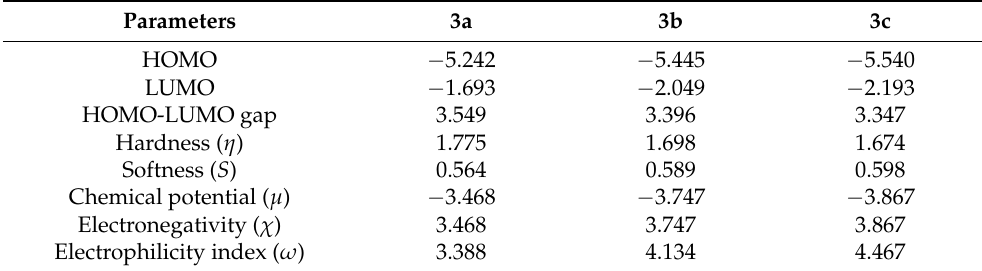
Table 2. DFT results for compounds 3a–c in terms of global reactivity